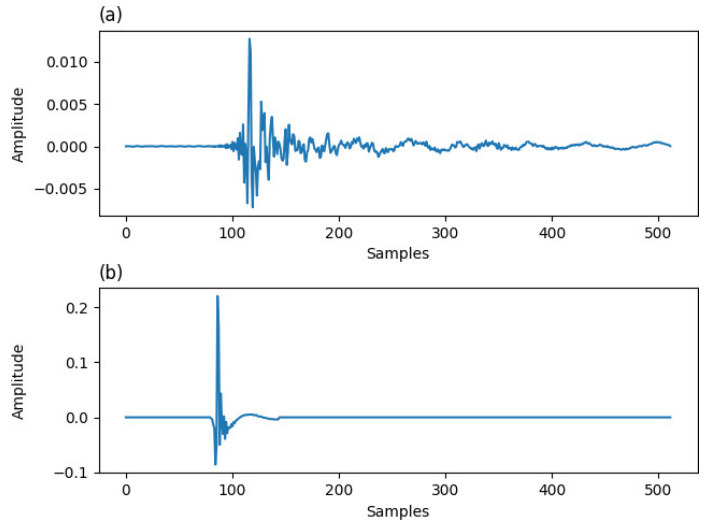
Figure 1. Echo paths used in simulations. ( a ) acoustic echo path and ( b ) network echo path (which is adapted from G168 Recommendation